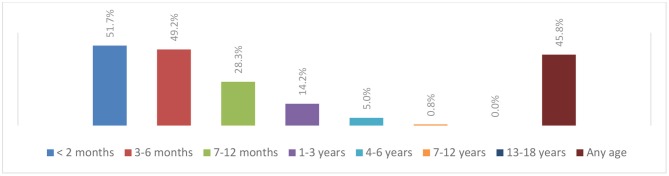
Patient's age from which pediatricians believe that a medical visit following a telephone consultation is mandatory, n = 120.